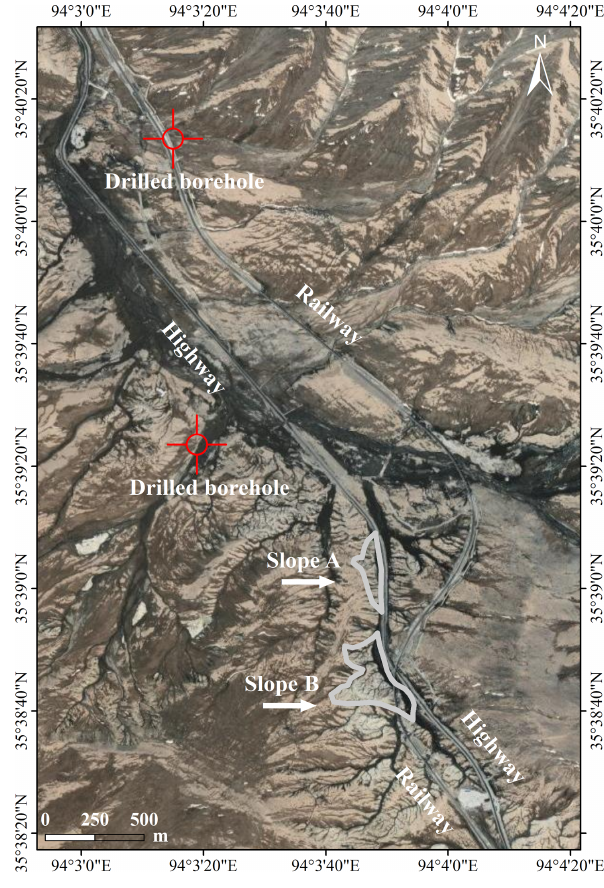
Figure B1. The location of two drilled